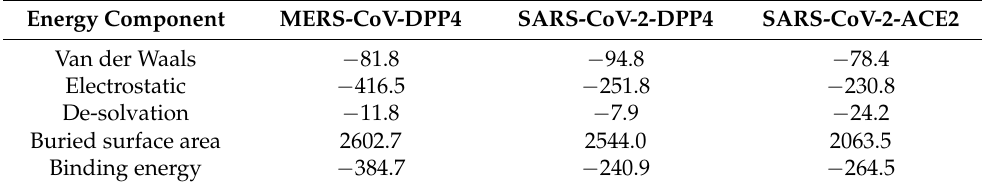
Table 1. Binding energies of the best docking poses in the MERS-CoV-DPP4, SARS-CoV-2-DPP4 and SARS-CoV-2-ACE2 complexes predicted by HADDOCK. All energies are reported in kJ/mol. Energy Component MERS-CoV-DPP4 SARS-CoV-2-DPP4 SARS-CoV-2-ACE2 Van der Waals − 81.8 − 94.8 − 78.4 Electrostatic − 416.5 − 251.8 − 230.8 De-solvation − 11.8 Buried surface